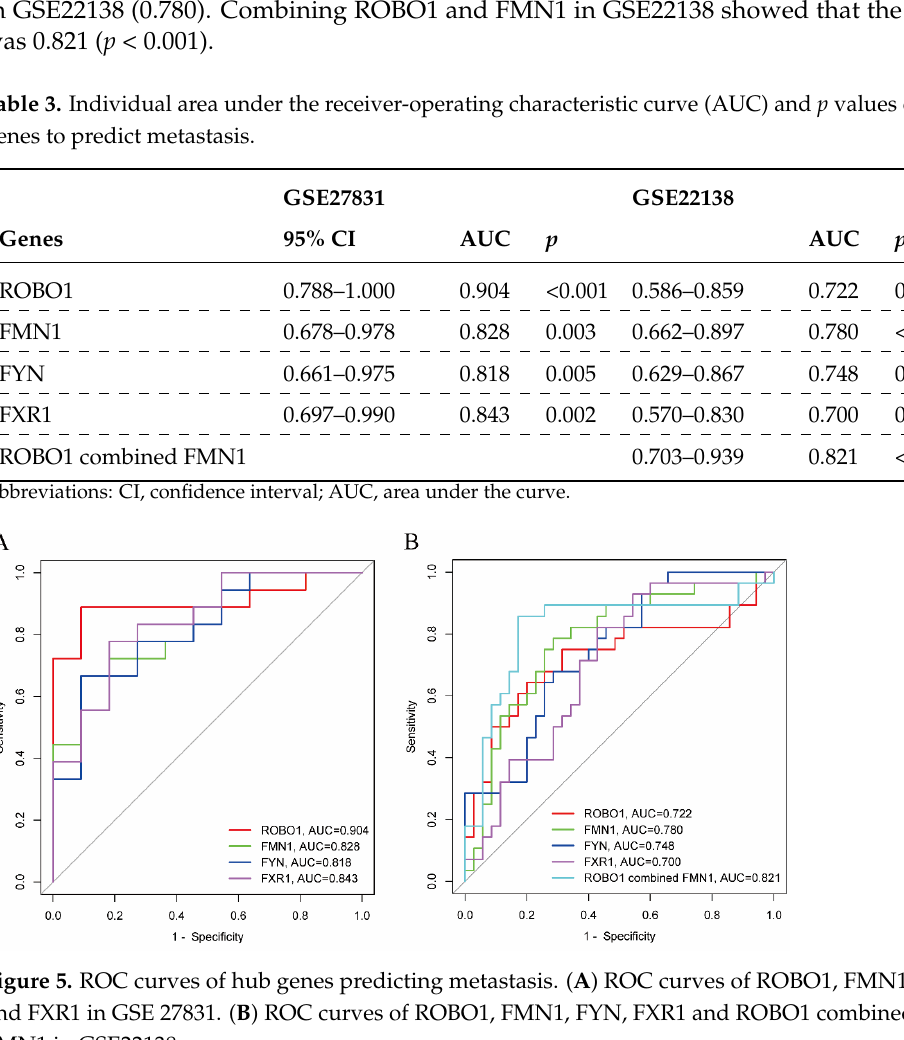
Table 2. Logistic regression analysis of hub genes affecting metastasis of the study patients.